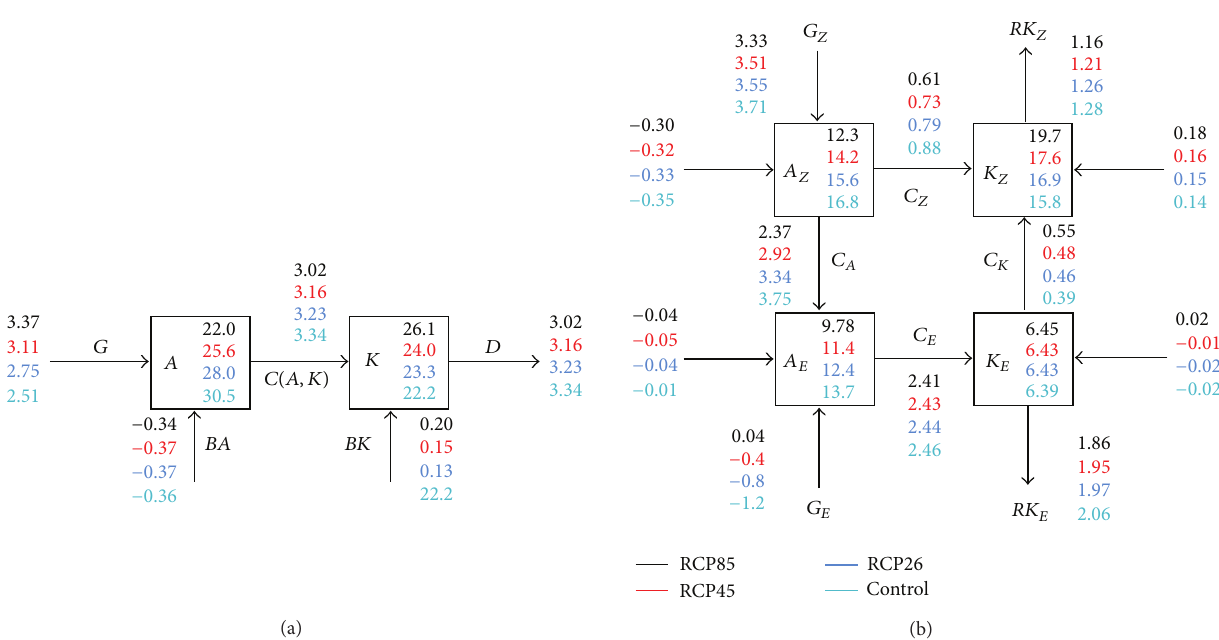
Figure 5: Representation of annual mean of spatial domain Lorenz energy cycle for the Southern Hemisphere in which (a) is representative of a two-component energy cycle and (b) denotes the four-component diagram. The boundaries of available potential energy (𝐵 𝐴 ) and kinetic energy (𝐵 𝐾 ) are included in the two-component energy cycle. Values from up to below in each figure are for RCP85, RCP45, RCP26, and control experiments. Units are 10 5 J/m 2 for reservoirs and W/m 2 for conversion, generation, and dissipation terms. Arrows indicate the direction corresponding to positive values; negative values imply opposite flux direction.